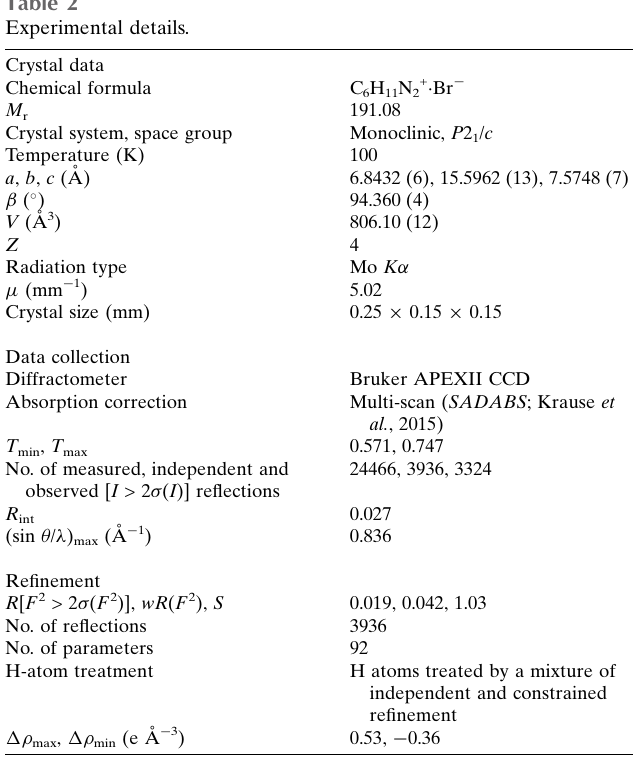
Table 2 Experimental details.